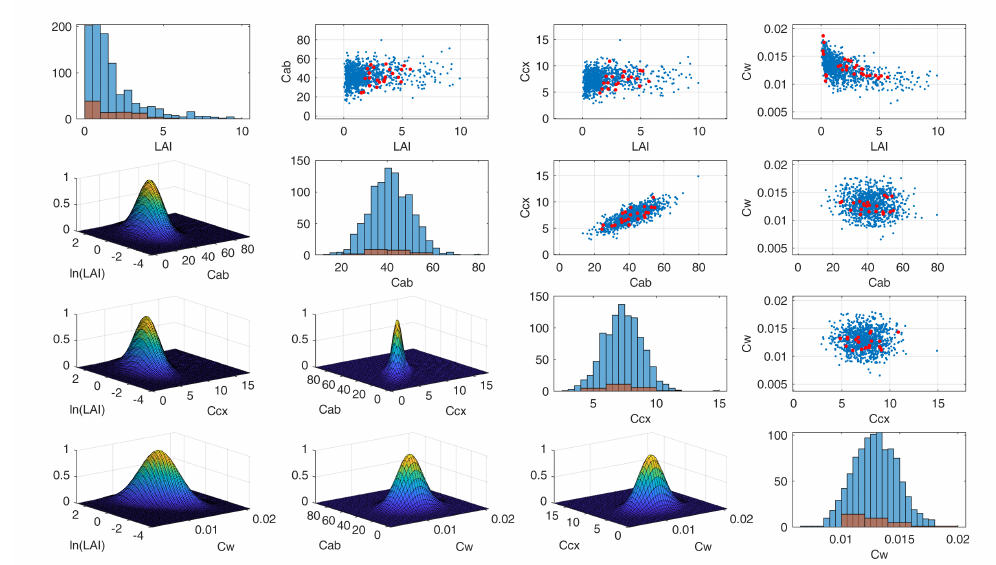
Figure 2. Example of PROSAIL-PRO random inputs generated from a multivariate normal PDF, considering covariance values among plant traits. Red dots in the scatter plots represent values measured during the Grosseto 2018 campaign; the blue dots are randomly sampled values used as input for the PROSAIL-PRO